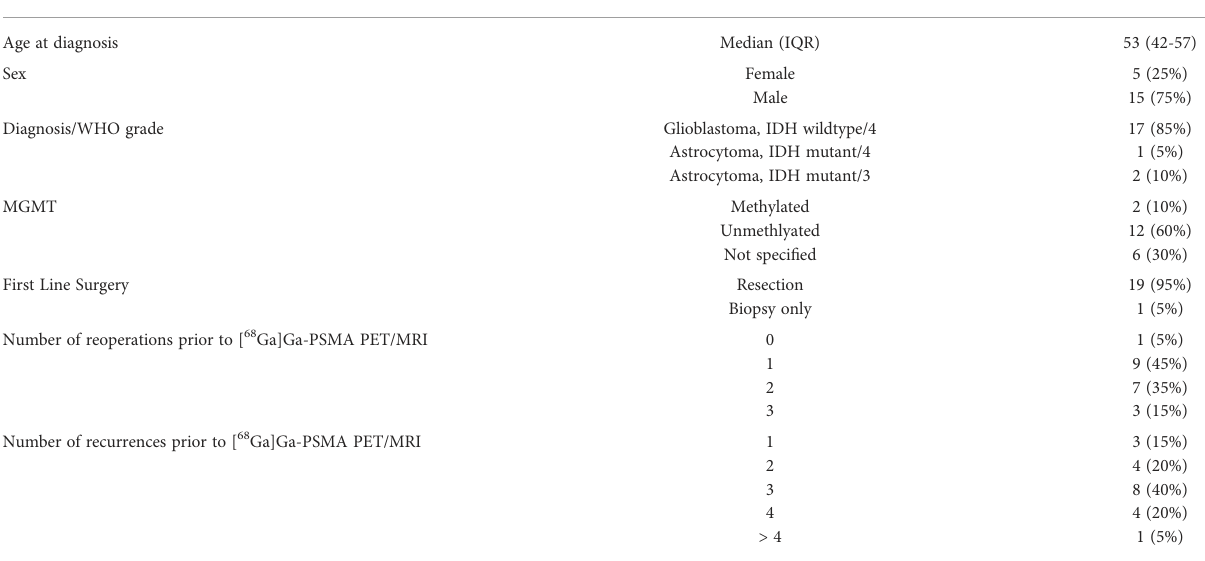
TABLE 1 Demographics and clinical